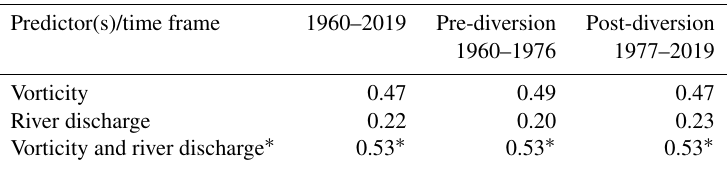
Figure 7. Sea-level atmospheric pressure (hPa) for coherent peaks in atmospheric vorticity and sea level at Churchill, highlighted in Fig. 6 with yellow lines: (a) 18 October 1969, (b) 25 November 1969, (c) 15 October 2003, and (d) 21 November 2003. Table 1. Correlations ( R ) of daily atmospheric vorticity and/or Churchill River discharge against sea-level anomalies in western Hudson Bay for the whole annual